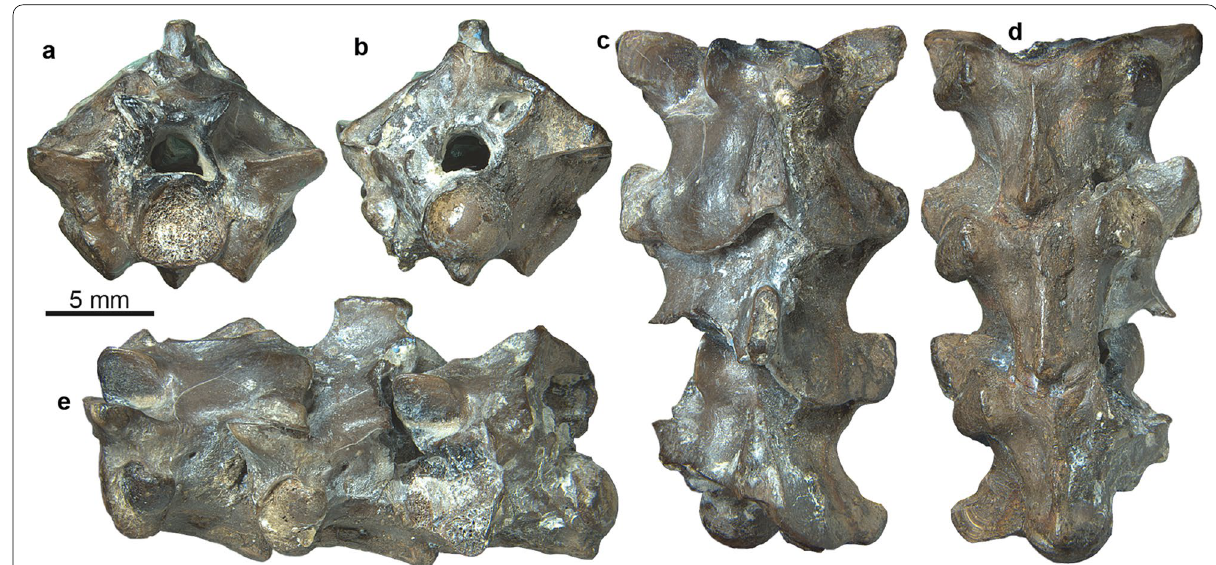
Fig. 50 Eoconstrictor fischeri from Messel, holotype (part) (SMF-ME 929): string of three articulated vertebrae in anterior ( a ), posterior ( b ), dorsal ( c ), ventral ( d ), and left lateral ( e ) views. This string was originally closely connected with the other part of the holotype, string of Figs. 48, 49, of which it was placed more